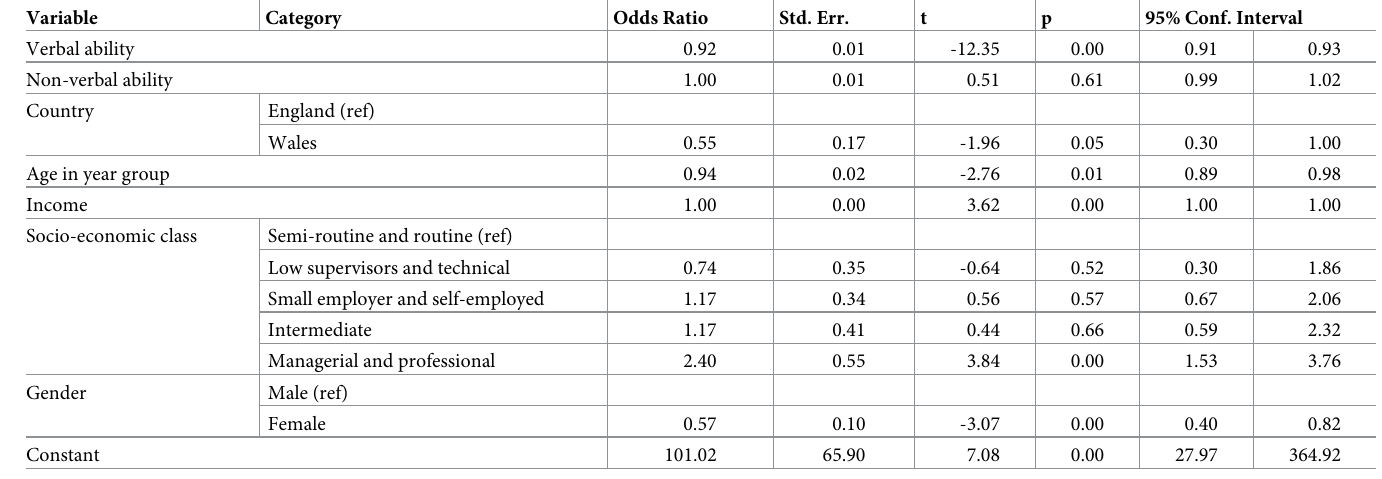
Table 4. Logistic regression predicting the dyslexia label at age